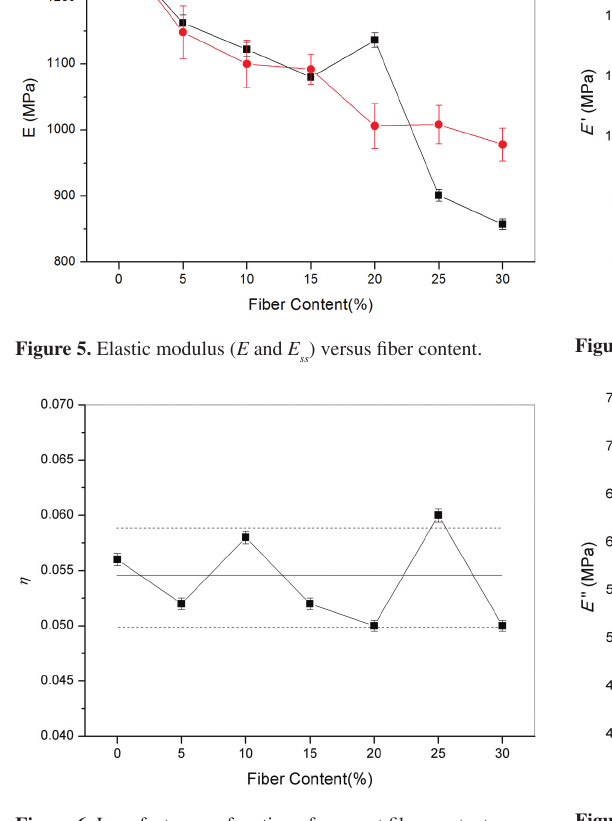
Figure 6. Loss factor as a function of coconut fiber